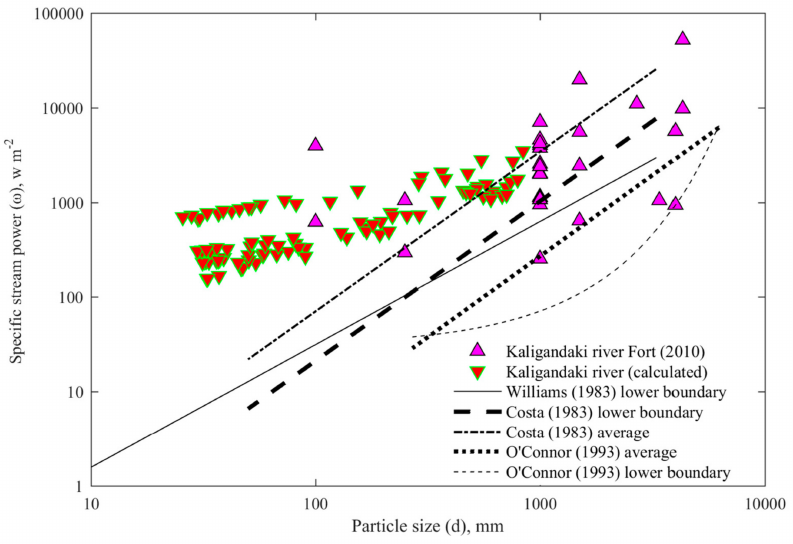
Figure 6. Relationship of the specific power and particle size (boulder) and a comparison with di ff erent researchers.